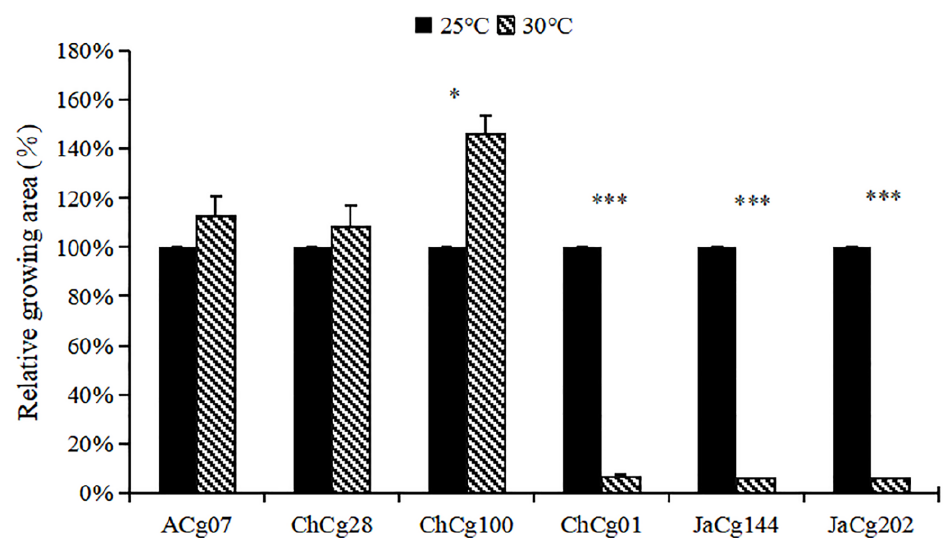
Figure 2. Relative mycelial growth area of the Cenococcum geophilum isolates. Relative mycelial area was calculated [(mycelial area at 30 °C)/(mycelial area at 25 °C)] ×100(%). The data showed the mean ± SD for 25 °C and 30 °C replicates ( n = 3). Significant difference in the relative mycelial growth area of the Cenococcum geophilum isolates between 25 °C and 30 °C was tested by the Stu- dent’s t test ( p < 0.05). *** p < 0.0001, * p < 0.05.